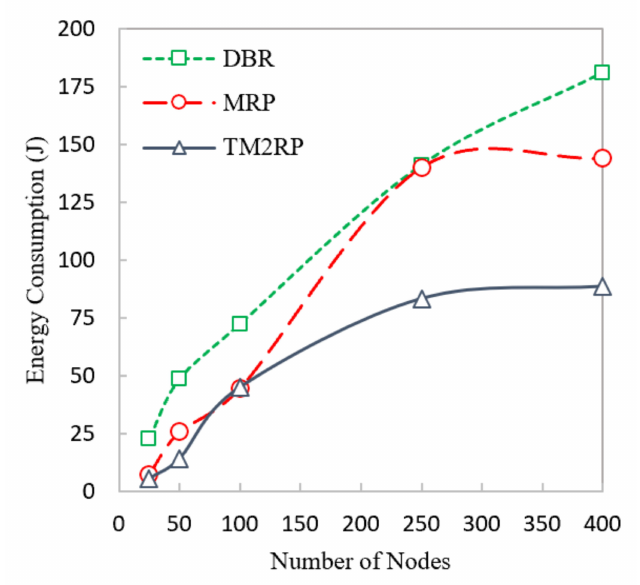
Figure 7. Comparison of underwater network energy consumption with number of sensor nodes.